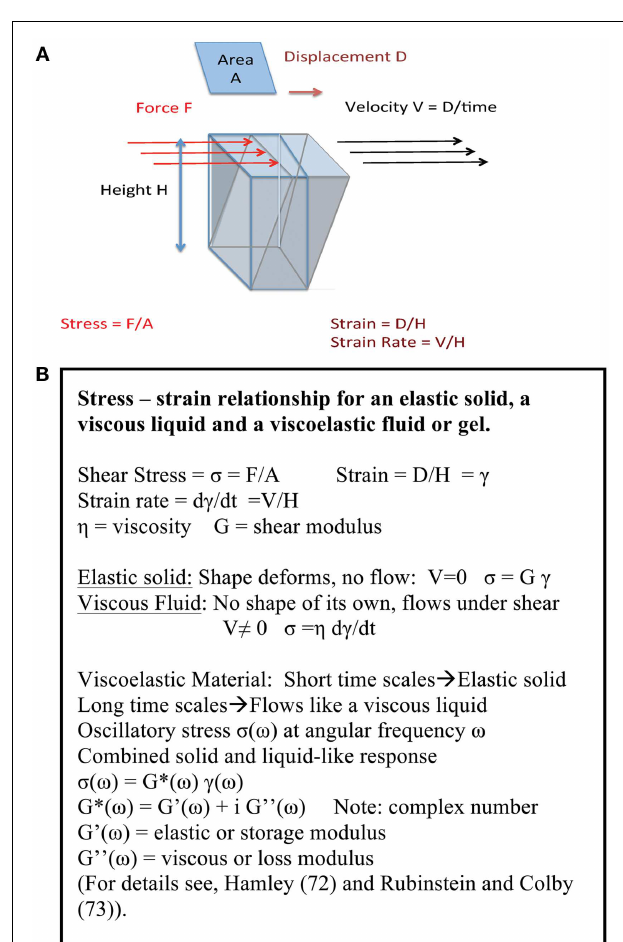
FIGURE 4 | (A) Key concepts of viscoelasticity . A rectangular object with a surface area A and height H , fixed at the bottom surface, is subjected to a shear force F by pushing along the top surface. If the object is a regular solid then the top surface displaces by an amount D deforming the object. If the object is a liquid between two plates, with the bottom plate fixed and the top plate pulled at a speed V , it flows with speed increasing from 0 at the bottom to V at the top, so the deformation is given by V / H . If it is viscoelastic, both solid-like and liquid-like deformations occur simultaneously, albeit on different time scales.The origin of viscoelasticity lies in the ease with which polymer chains can be deformed, and the fact that their motion is controlled by transient entanglements and long-lived crosslinks between chains. (B) Summary of stress – strain relationship . The basic definitions for an elastic solid, a viscous liquid and a viscoelastic fluid or gel are summarized here.